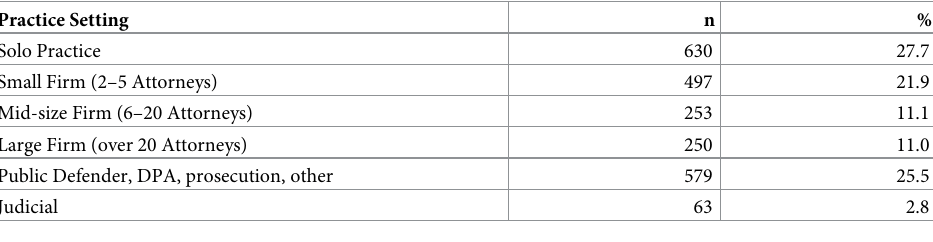
Table 2. Primary practice setting of respondents (n =